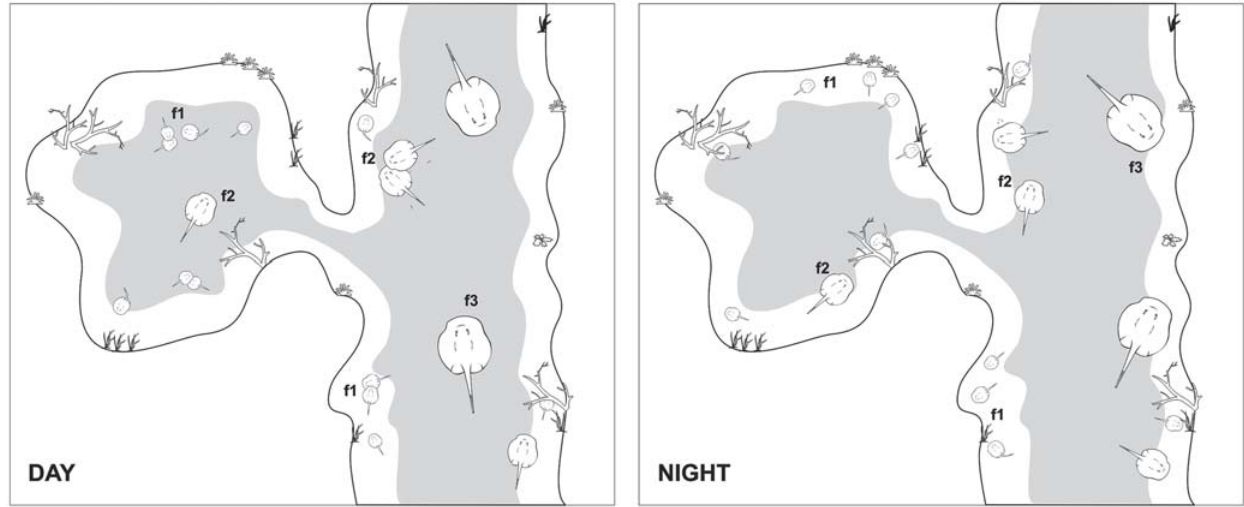
Fig. 3. Distribution of individuals of P. falkneri and P. motoro of three size classes ((f1 = DW 15-25 cm, f2 = DW 26-45 cm, and f3 = DW 46-65 cm)) in the upper Paraná River, illustrating the daily variation (day and night) in the occupation of shallower marginal areas (in white) and deeper central areas (in gray), both in marginal lakes and in the main river channel.